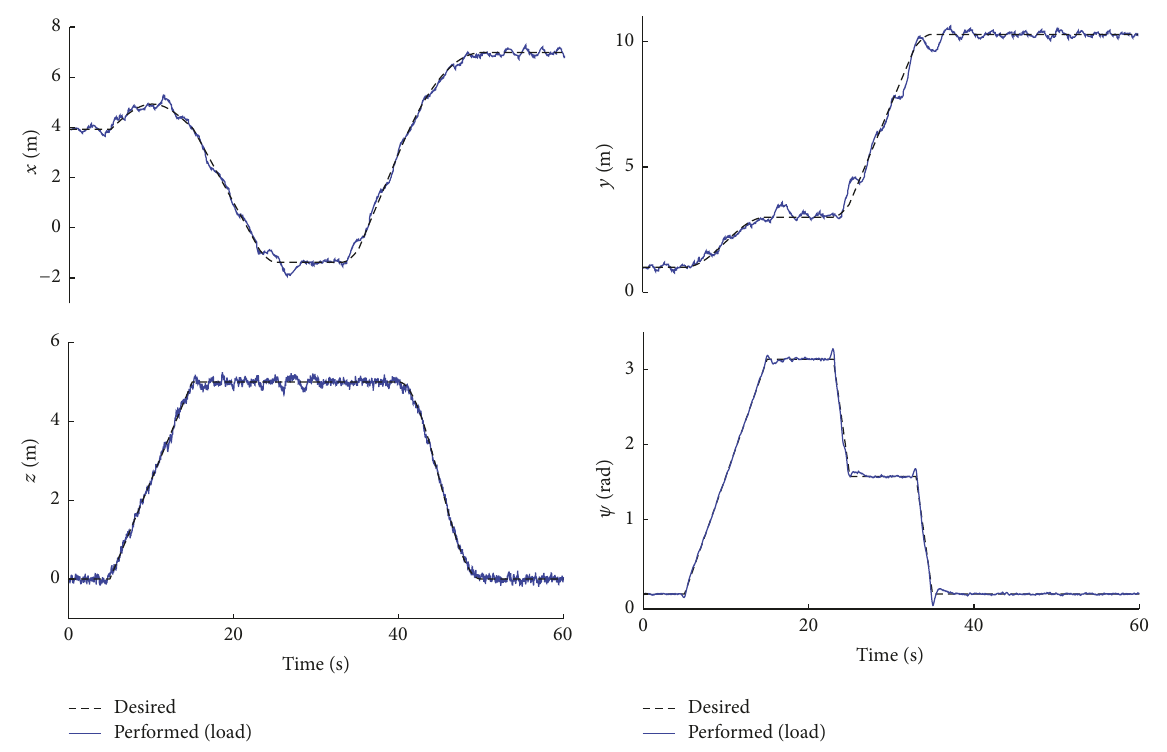
Figure 7: Time evolution of the regulated variables ( 𝑥,𝑦,𝑧, 𝜓 ) and their desired trajectories.